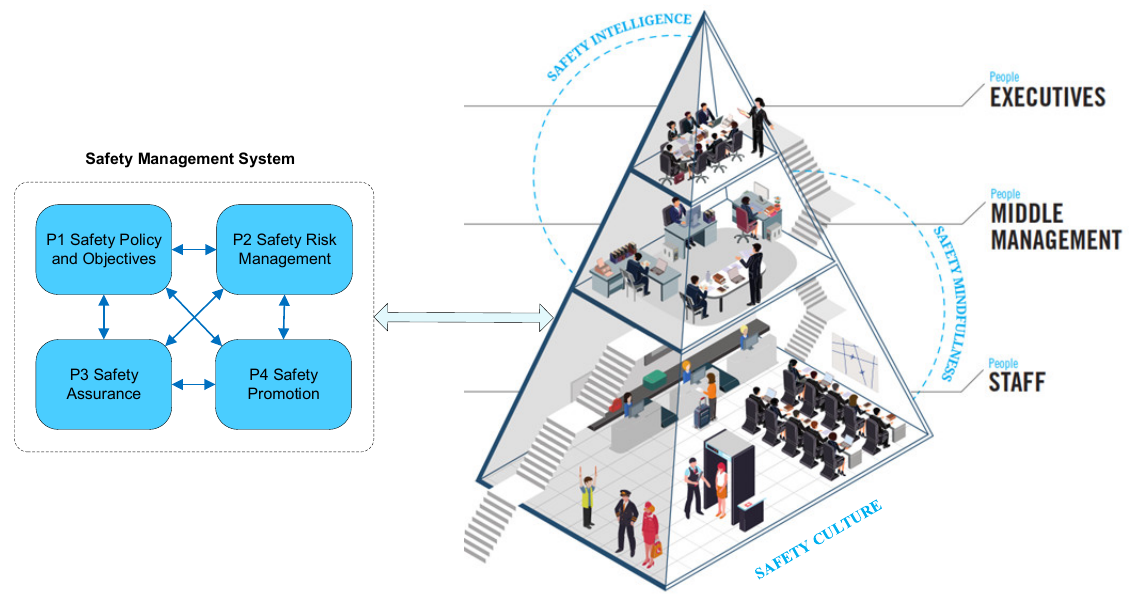
Figure 1. Safety management system and safe performance in an organisation.